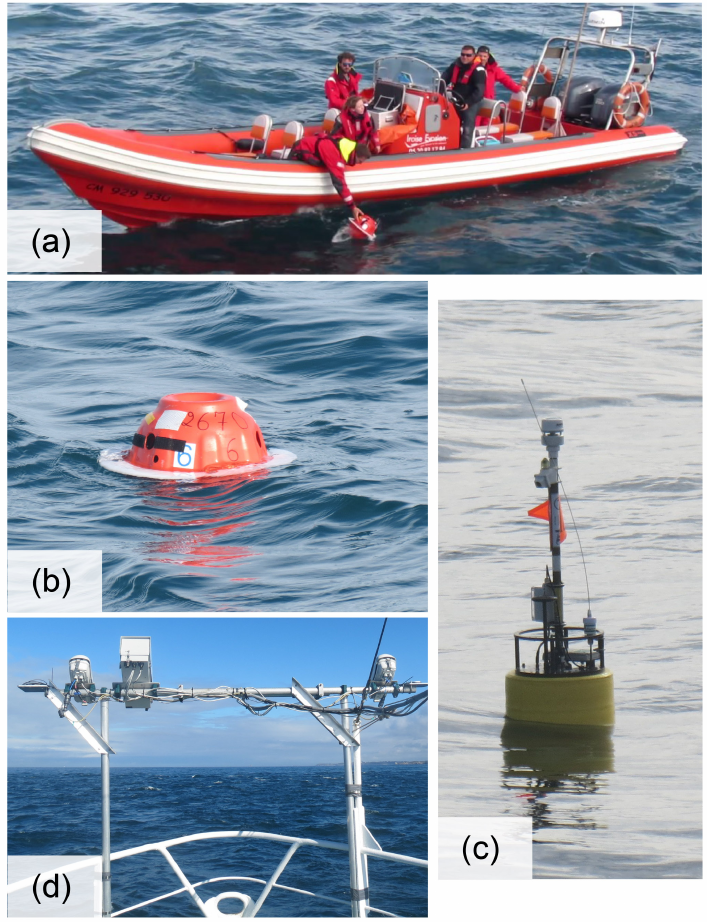
Figure 2. Sensors used during oceanographic campaigns for in situ validation. (a) SKIB deployment; (b) SKIB buoy; (c) SWIFT buoy; (d) stereo-video